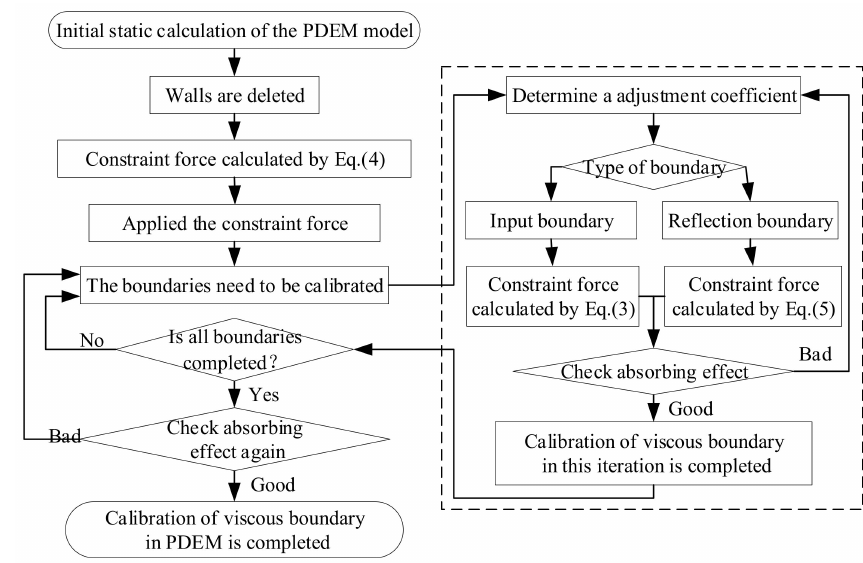
Figure 1. Application of the viscous boundary in the